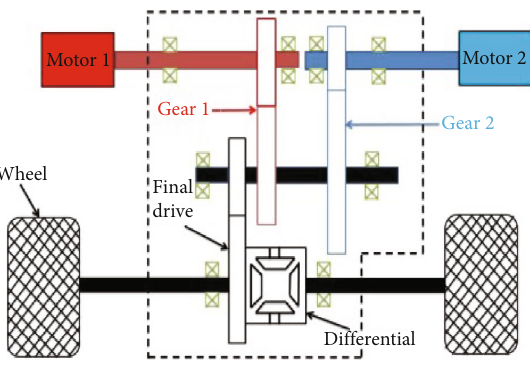
Figure 1: Overview of the hybrid drivetrain